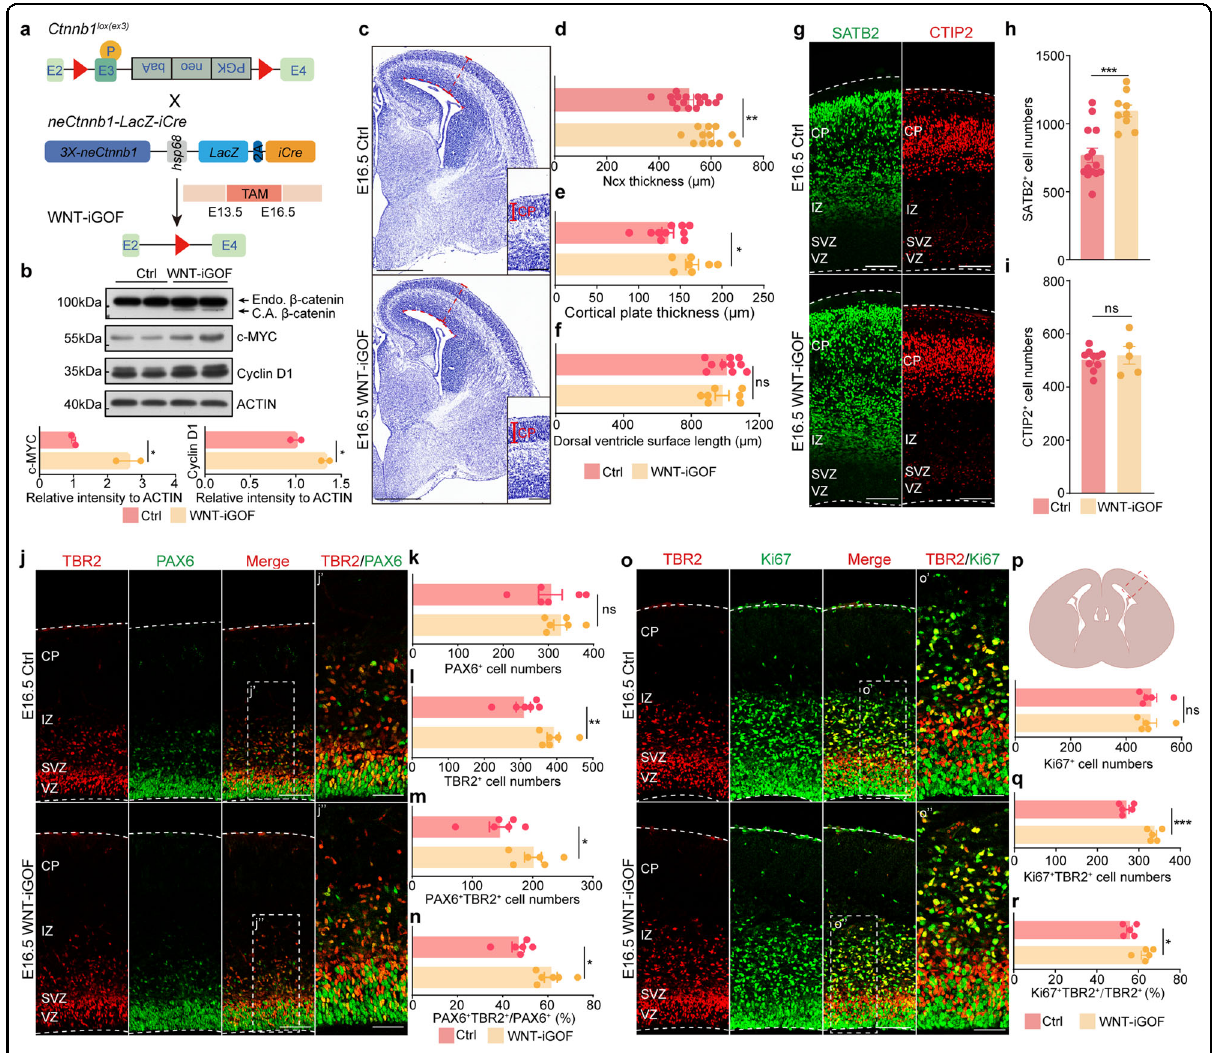
Fig. 4 Stabilization of β -catenin in neCtnnb1 -active cells promotes the production and transit-ampli fi cation of IPs in developing neocortices. a Schematics show mating of Ctnnb1 lox(ex3) mice with neCtnnb1-LacZ-iCre mice. Pregnant mice were injected with tamoxifen (TAM) at E13.5 and sacri fi ced at E16.5. b Top: immunoblotting of β -catenin, c-MYC, Cyclin D1 and ACTIN using protein lysates of Ctrl - Ctnnb1 lox(ex3) and WNT- iGOF - neCtnnb1-LacZ-iCre ; Ctnnb1 lox(ex3) neocortices. Bottom: histograms show protein levels of c-MYC and Cyclin D1 normalized to ACTIN levels. Values of Ctrl neocortices were set as ‘ 1 ’ . C.A. β -catenin, the constitutively active (non-degradable) β -catenin caused by deletion of Ctnnb1 ’ s exon 3; Endo. β -catenin, endogenous β -catenin. c Nissl-staining on E16.5 Ctrl and WNT-iGOF coronal brain sections. d Comparison of neocortical thickness of E16.5 Ctrl and WNT-iGOF mice. n = 16 for Ctrl brains and n = 12 for WNT-iGOF brains. Each point represents an individual brain. e Comparison of cortical plate thickness of E16.5 Ctrl and WNT-iGOF mice. n = 10 for Ctrl brains and n = 7 for WNT-iGOF brains. Each point represents an individual brain. f Comparison of dorsal ventricle surface length of E16.5 Ctrl and WNT-iGOF mice. n = 10 for Ctrl brains and n = 7 for WNT-iGOF brains. Each point represents an individual brain. g – i Immuno fl uorescence ( g ) and quanti fi cation ( h , i ) of SATB2 + and CTIP2 + of coronal sections of E16.5 Ctrl and WNT-iGOF Ncx. j – n Immuno fl uorescence ( j ) and quanti fi cation ( k – n ) of of TBR2 + (red) and PAX6 + (green) cells on boxed area of E16.5 coronal sections ( p ) of Ctrl and WNT-iGOF Ncx. n = 6 for Ctrl brains and n = 6 for WNT-iGOF brains. Each point represents an individual brain. o – r Immuno fl uorescence ( o ) and quanti fi cation ( p – r ) of TBR2 + (red) and Ki67 + (green) cells on boxed area of coronal sections ( p ) of E16.5 Ctrl and WNT-iGOF Ncx. n = 5 for Ctrl brains and n = 5 for WNT-iGOF brains. Each point represents an individual brain. Quanti fi cation data are shown as means ± SEM. Statistical signi fi cance was determined using an unpaired two-tailed Student ’ s t -test ( d , e , f , h , i , k – n and p – r ). *P < 0.05, **P < 0.01, and ***P < 0.001. ns not signi fi cant. Scale bars, 500 μ m ( c ), 100 μ m ( g , j , o and magni fi ed views in c ). 50 μ m (magni fi ed views in j and o